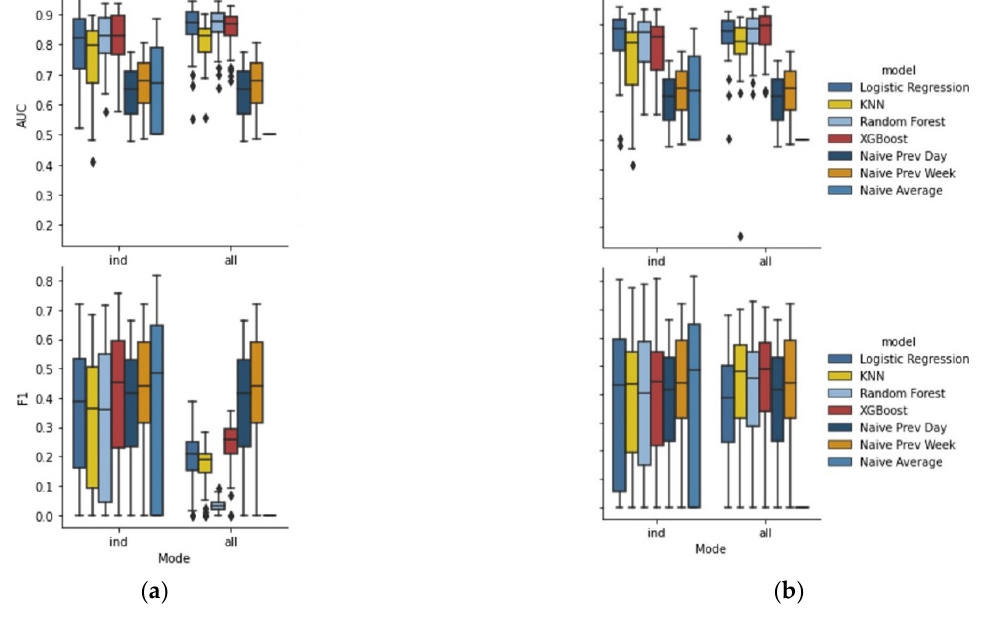
Figure 3. ( a ) AUC and F1 score for the different models and modes at Caltech for standard feature set; ( b ) AUC and F1 score for the different models and modes at Caltech for augmented feature set. To further investigate which mode is favorable, we examined all predictions of the four models: LogR, KNN, RF and XGBoost with a F1 score equal to 0. On the left, Figure 4 shows the F1 and AUC score for all charging points with a F1 score of 0 for the mode ‘individual’ and the corresponding pair for the same charging point for mode ‘all’. On the right, the mode ‘all’ and F1 scores equal to 0 are displayed with the corresponding score pair for mode ‘individual’.